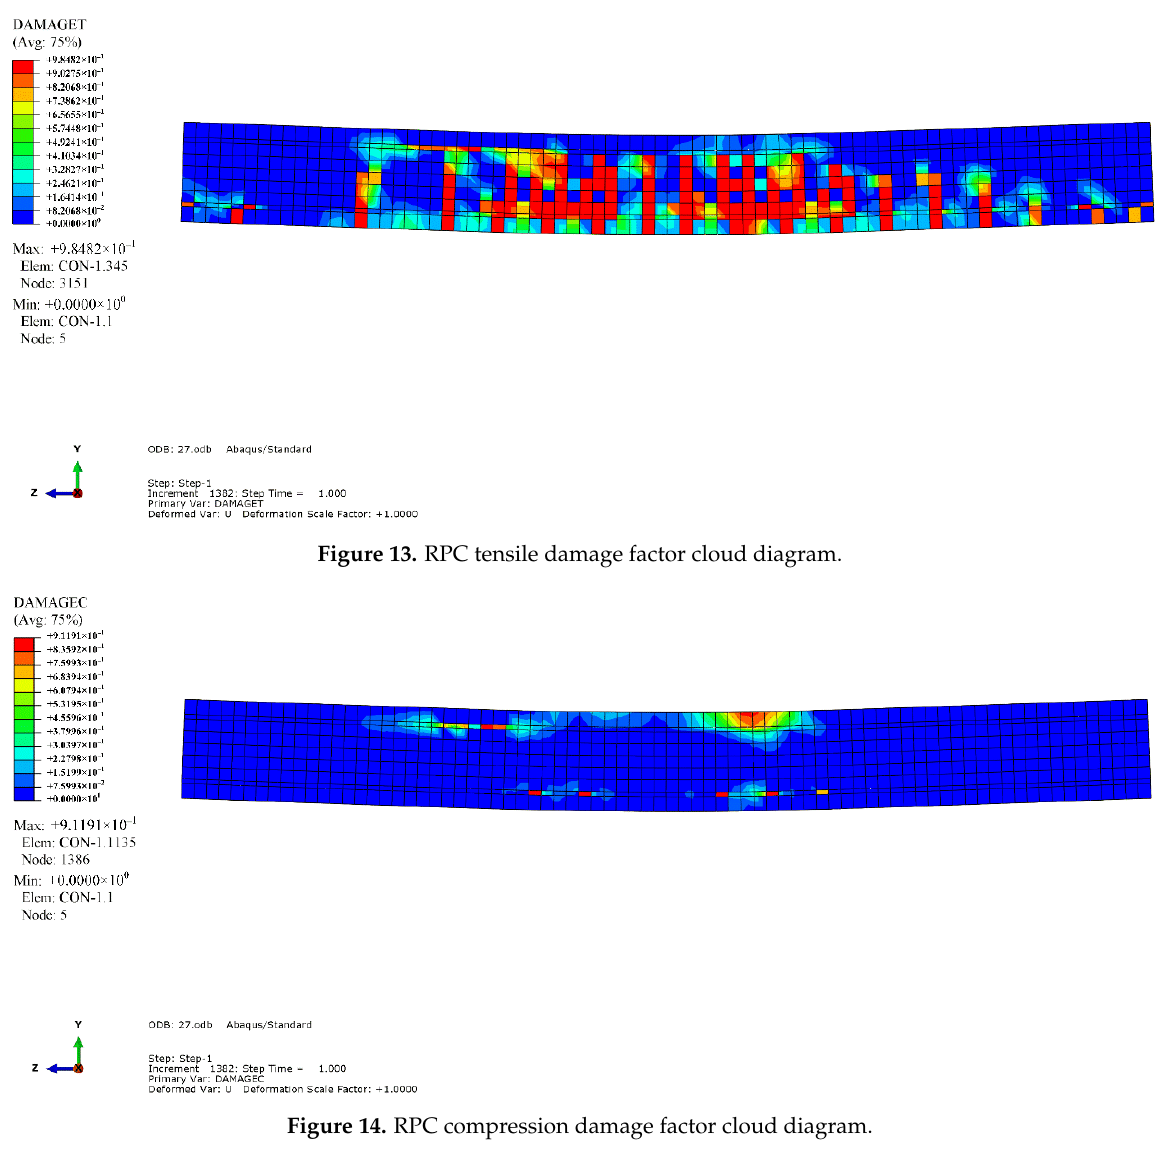
Figure 14. RPC compression damage factor cloud